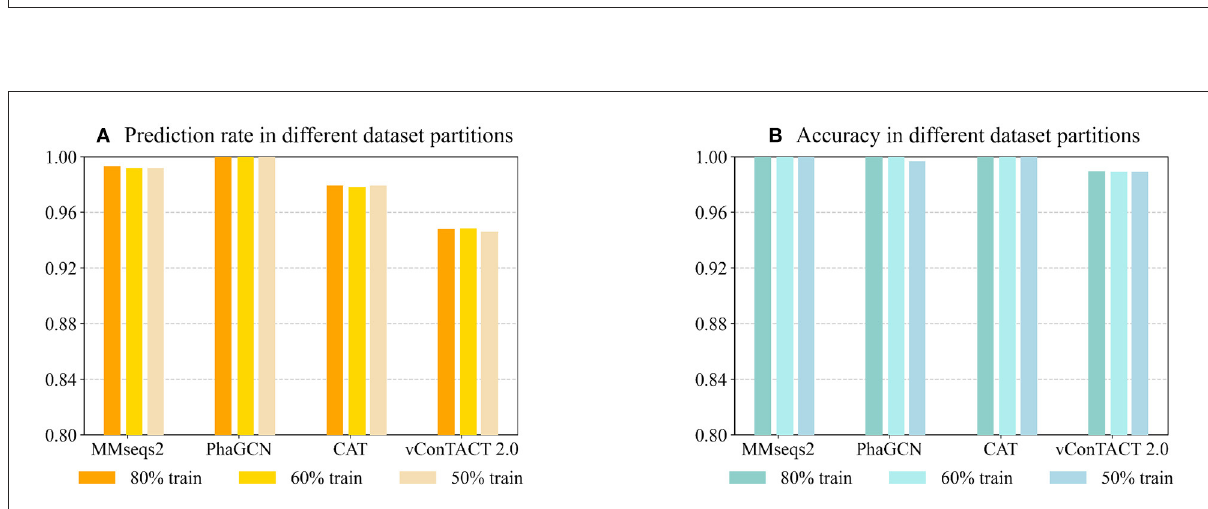
FIGURE5 (A) The prediction rate of four tools with reduced reference datasets. (B) The corresponding accuracy on sequences with predictions. X-axis: The tools and training data partitions Y-axis: The